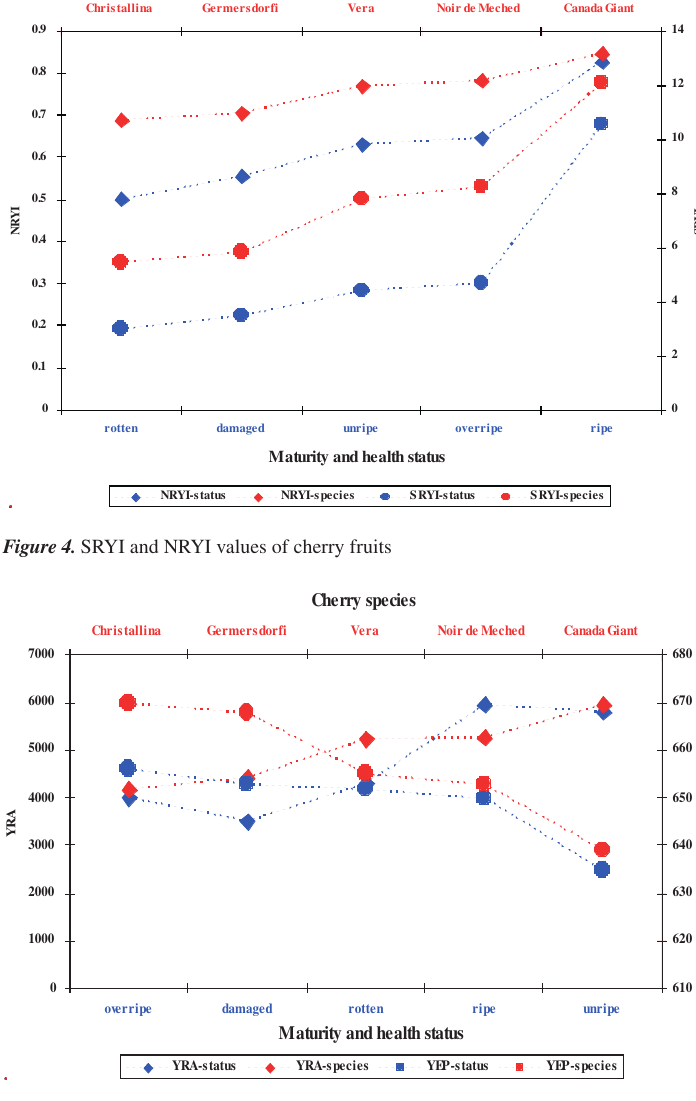
Figure 5. YRA and YEP values of cherry